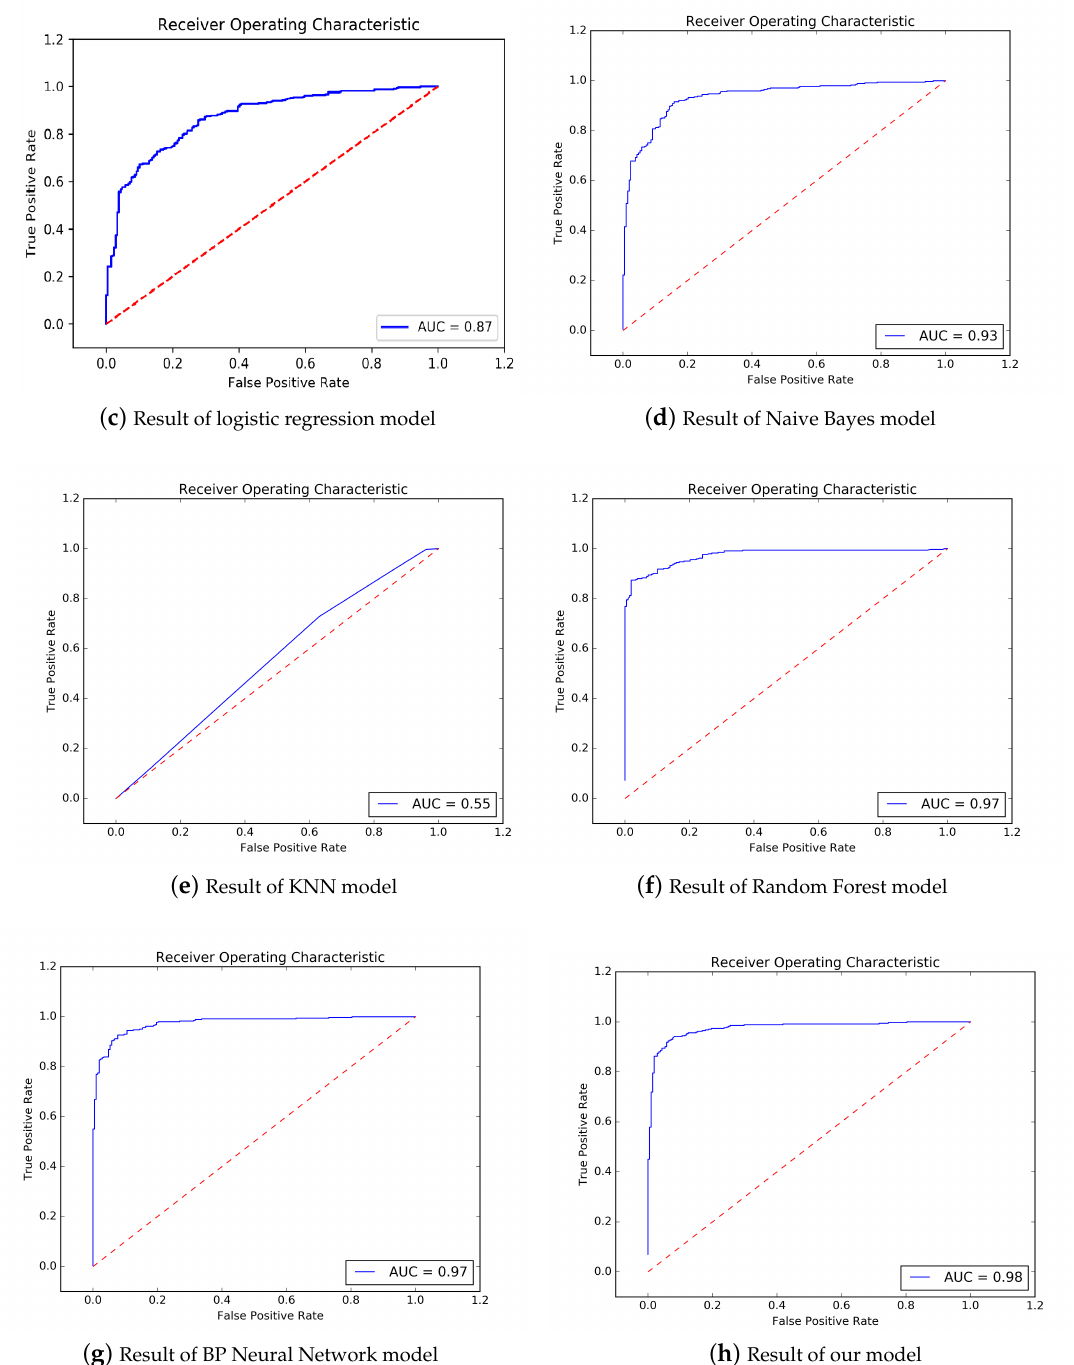
Figure 6. Comparison of